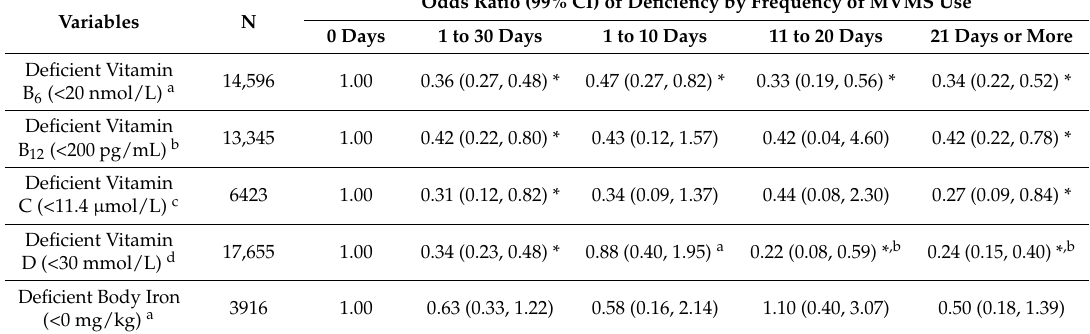
Table 3. Impact of MVMS intake frequency on odds ratios of risk of being below defined deficiency level for certain nutrients in